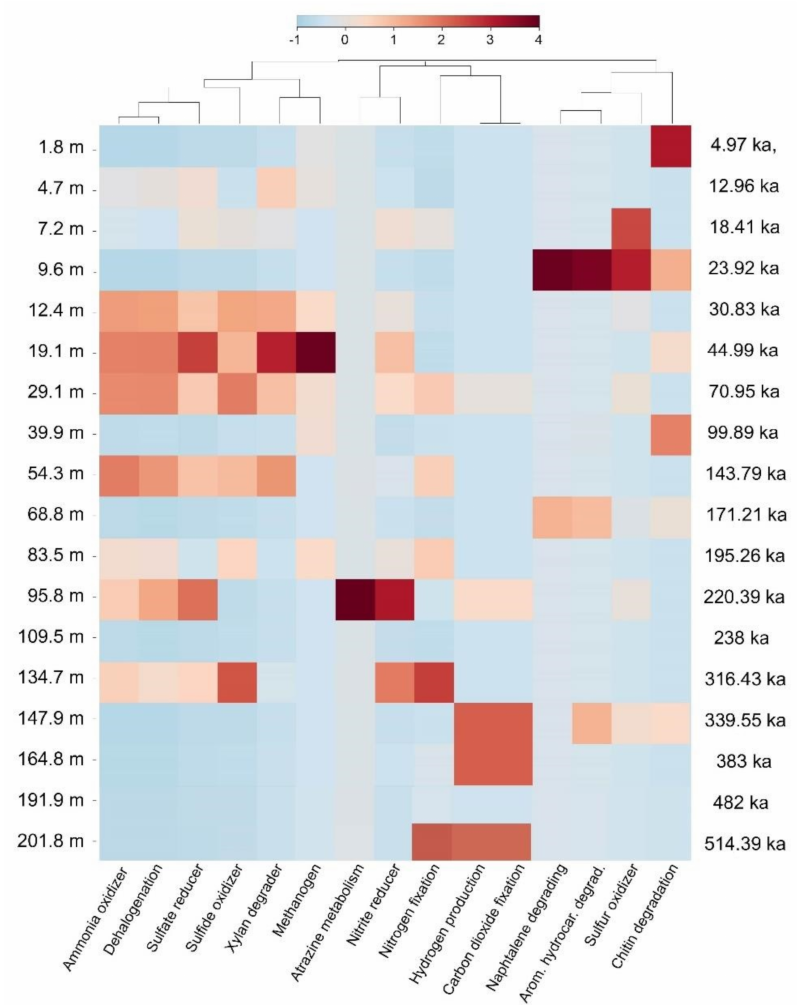
Figure 8. Heatmap of potential microbial metabolisms predicted for each sediment depth using the bioinformatics tool METAGENassist. Note that 25% of OTUs recovered were included in this analysis. Color scale of METAGENassist-provided normalized OTU abundances from − 1 to